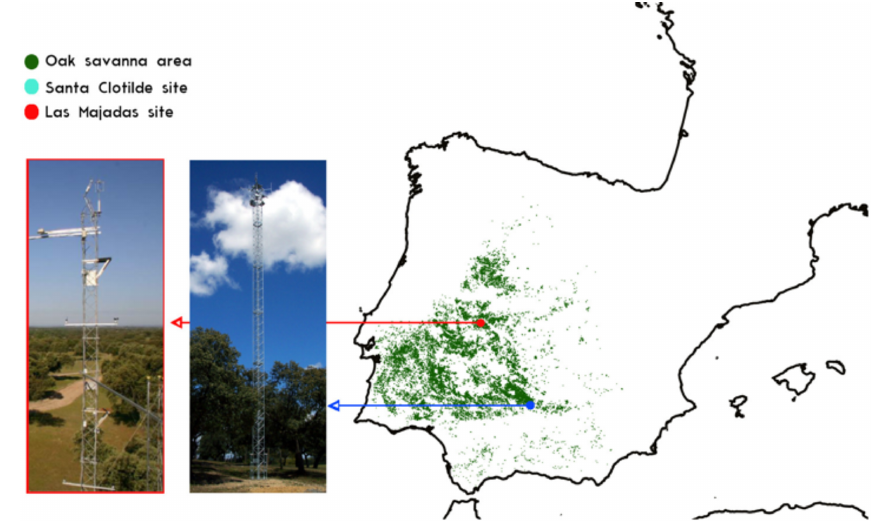
Figure 1. Distribution of oak savanna area in the Iberian Peninsula. Location of Sta.Clo (Santa Clotilde) and ES-LMa (Las Majadas) valida- tion sites and pictures of both eddy covariance flux